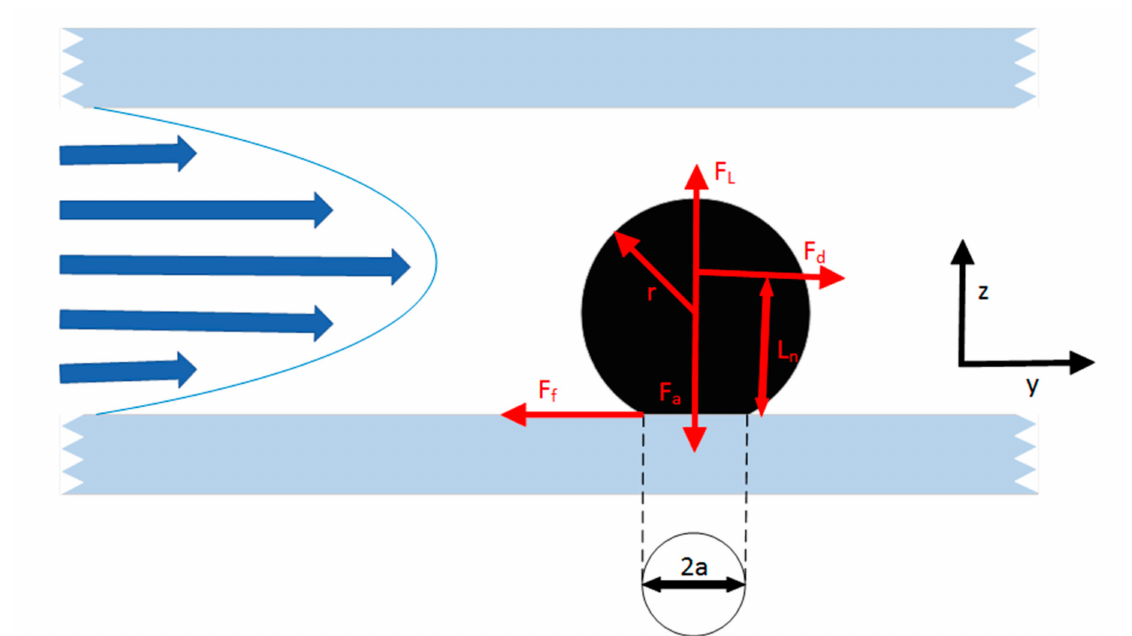
Figure 2. Force of particles in